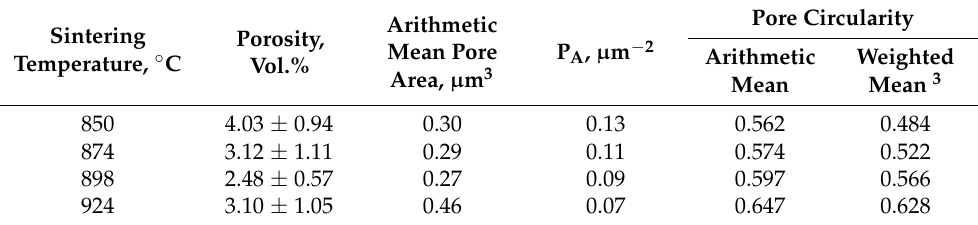
Table 7. Effect of sintering temperature on porosity, pore size, and shape.